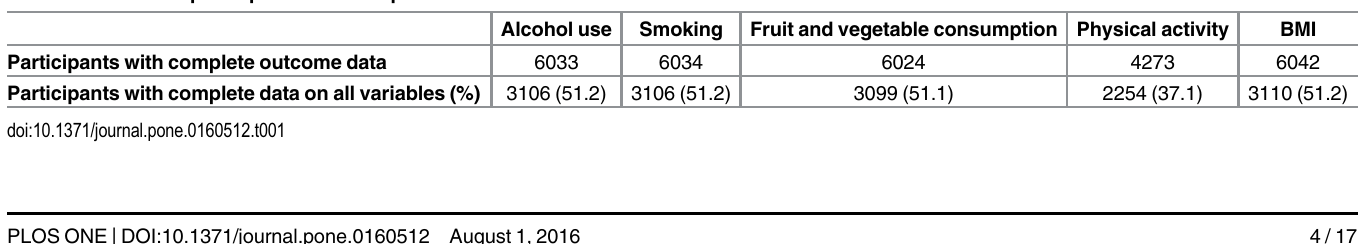
Table 1. Number of participants with complete data.